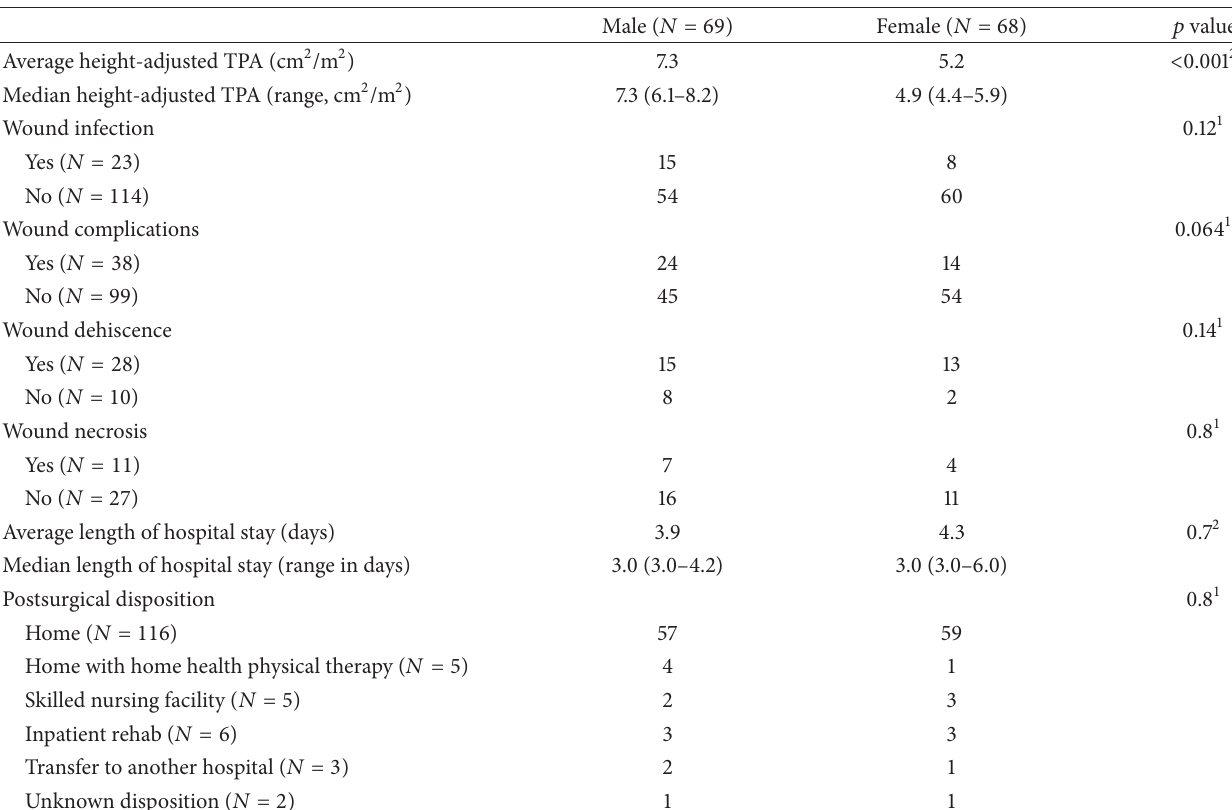
Table 2: Outcome variables by gender.